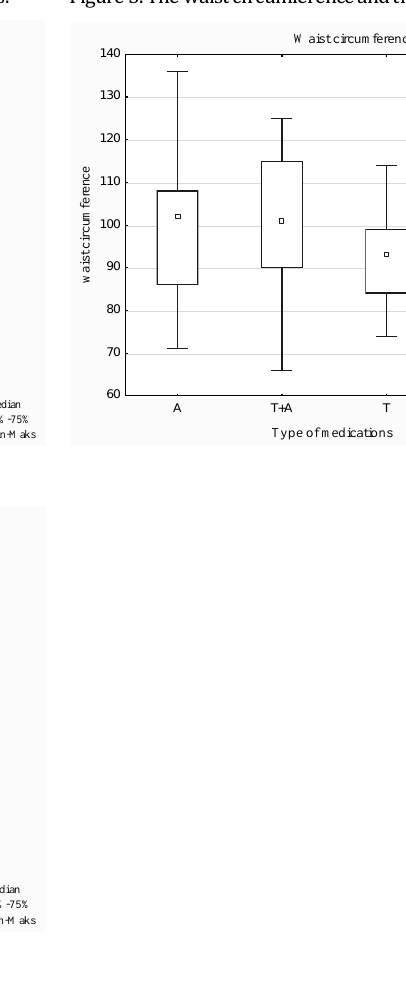
Figure 2.The body mass and the type of taken medications. Figure 3. The waist circumference and the type of taken medications